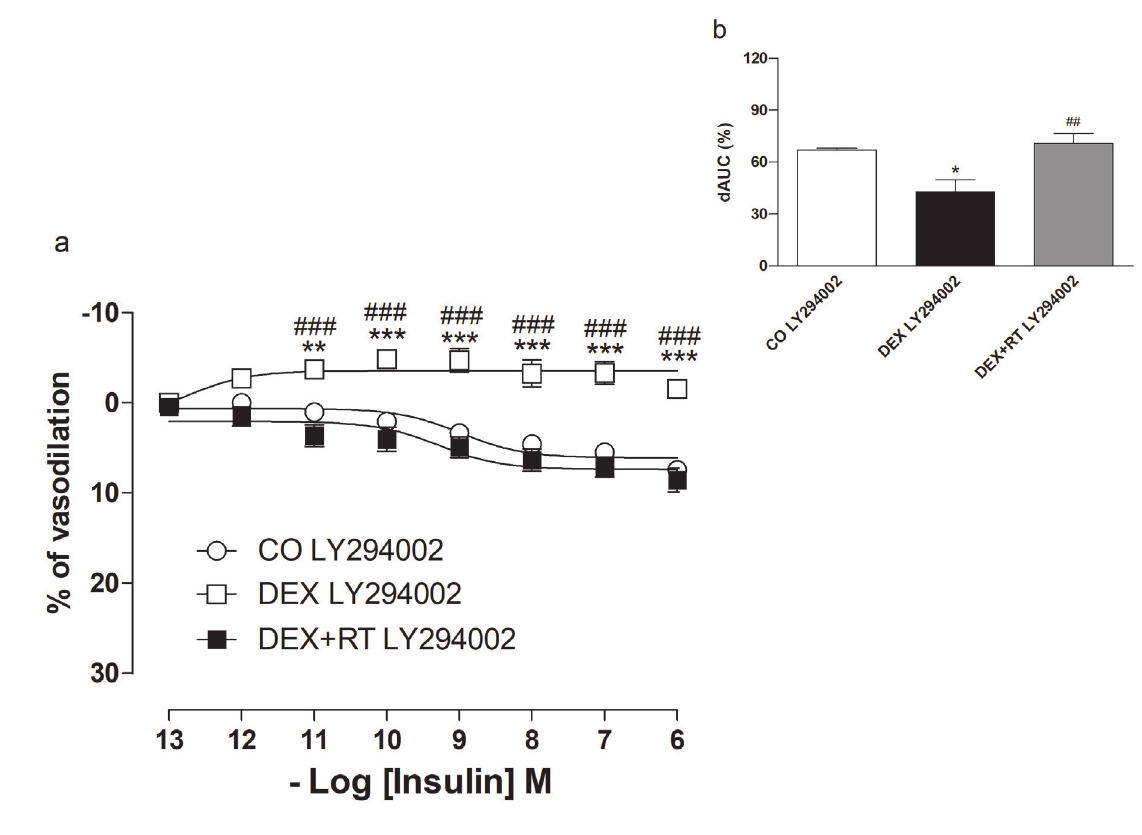
Figure 2. Cumulative concentration-response curve to insulin in intact segments obtained from the superior mesenteric artery of Wistar rats and pre-contracted with phenylephrine (1 μM) in the control (CO), dexamethasone-treated (DEX) and dexamethasone + resistance training (DEX+RT) groups, in the presence of LY294002 (50 μM) (a), and the difference in the area under the concentration–response curve (dAUC) for the response to insulin is shown for the CO, DEX and DEX+RT groups (b). The results are expressed as the mean ± SEM for 8–10 experiments in each group. **p< 0.01 ***p< 0.001, CO vs. DEX; ### p< 0.001, DEX vs.